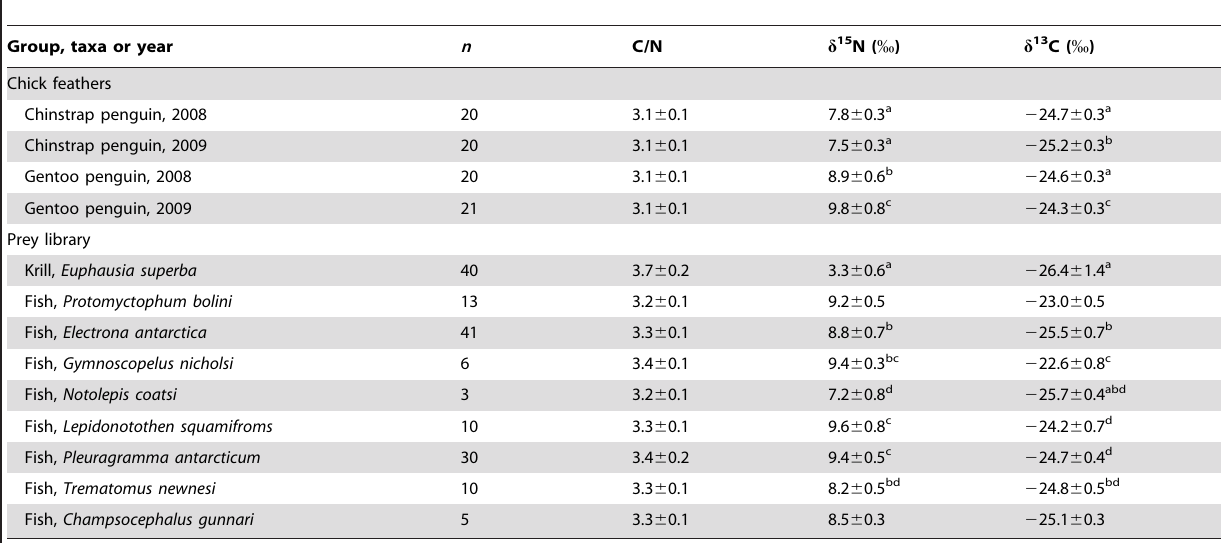
Table 2. The carbon to nitrogen ratio and stable isotope signatures of penguin chick feathers and nine common krill and fish prey